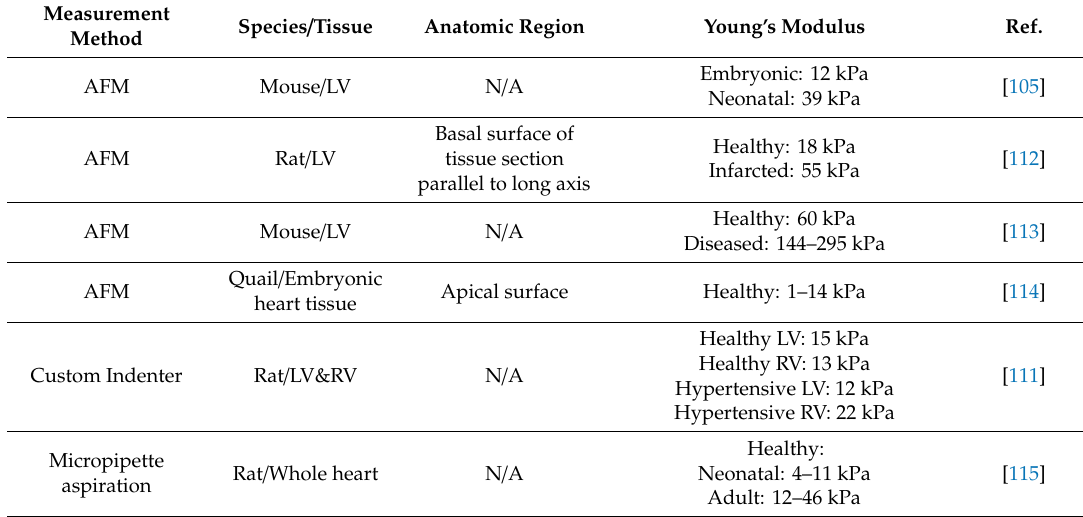
Table 3. Di ff erent Young’s moduli reported for the left or right ventricular (LV / RV) tissues. * are data estimated from the original papers. Tissue mechanical property is measured either in main fiber and cross-fiber (X-fiber) directions or in anatomical directions (L: longitudinal (long-axis of ventricle), C: circumferential (short-axis of